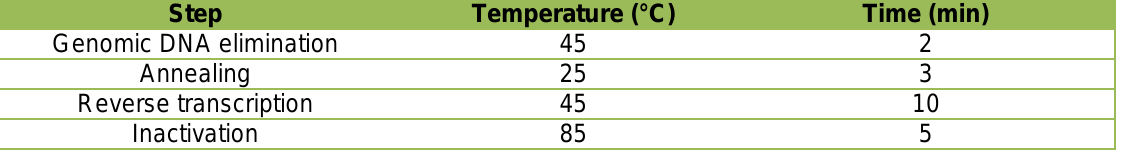
Table 2: Thermocycling conditions of the reverse transcription reaction